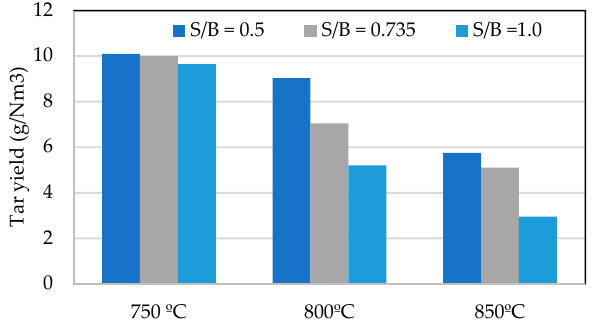
Figure 9. Effect of the temperature and S/B ratio on tar yields.